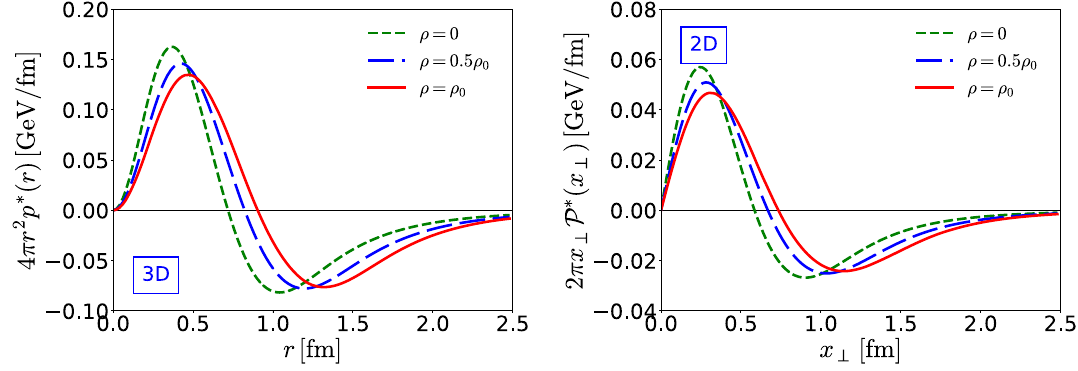
Fig. 5 3D and 2D pressure distributions of the nucleon as functions of the nuclear density ρ , multiplied by 4 π r 2 and 2 π x ⊥ , respectively. The short-dashed, long-dashed, and solid curves represent the pressure distributions with ρ = 0 , 0 . 5 ρ 0 ,ρ 0 , respectively. ρ 0 denotes the normal nuclear matter